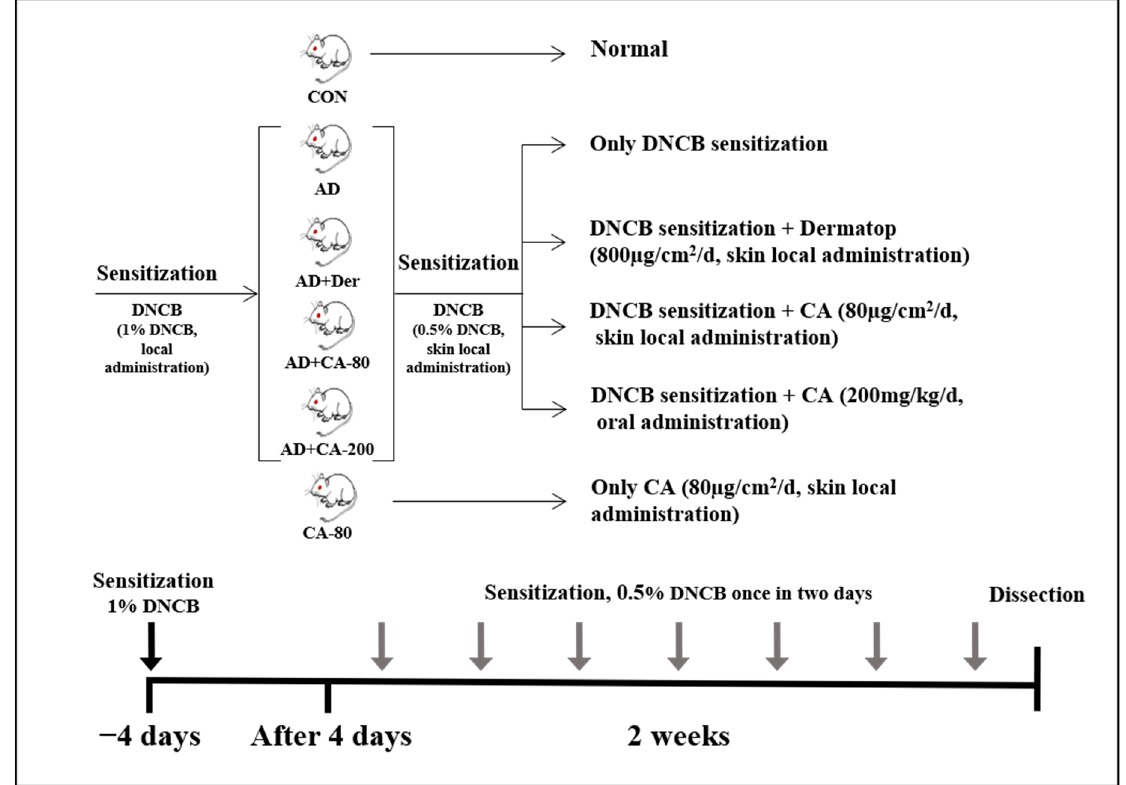
Figure 1. Experimental design of atopic dermatitis (AD) -like skin lesions mice model. BALB/c mice were randomly divided into six groups ( n = 8 per group). AD-like skin lesions were evoked by administering 1% 2,4-dinitrochlorobenzene (DNCB). 200 µL of 0.5% DNCB was applied on each ear, and after 4 days. DNCB was alternatively repeatedly treated once in two days for 2 weeks. Centella asiatica ethanol extract (CA) was administrated by skin local administration (80 µg/cm 2 /d) and oral administration (200 mg/kg/d). The Dermatop was skin local administrated (800 µg/cm 2 /d). Without inducing AD, CA (80 µg/cm 2 /d) was skin locally administrated for 2 weeks.